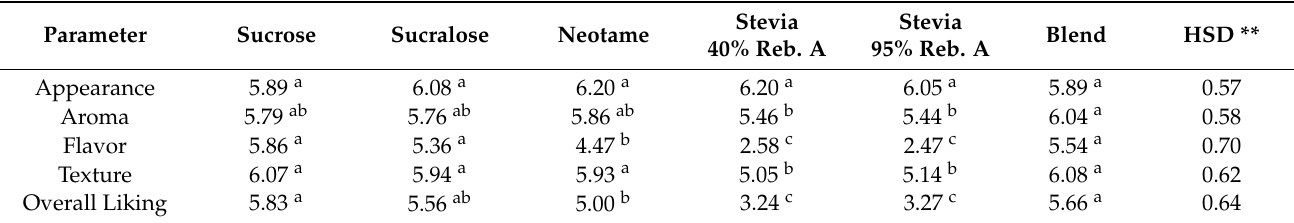
Table 5. Means * of overall liking of consumer